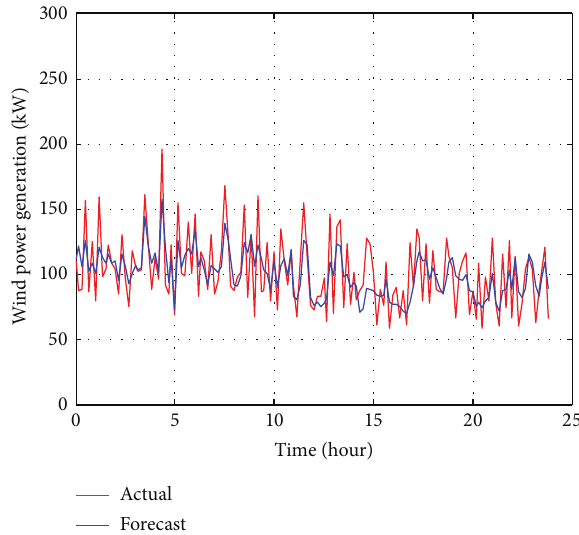
Figure 6: Numerical results with the back propagation neural network method for typical winter day.